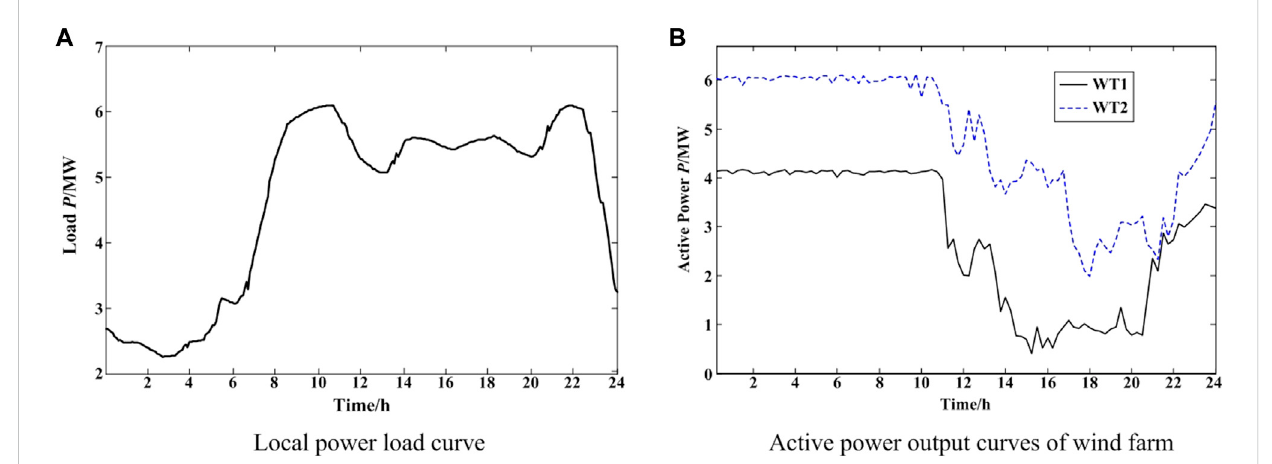
FIGURE 11 Diagram of engineering case